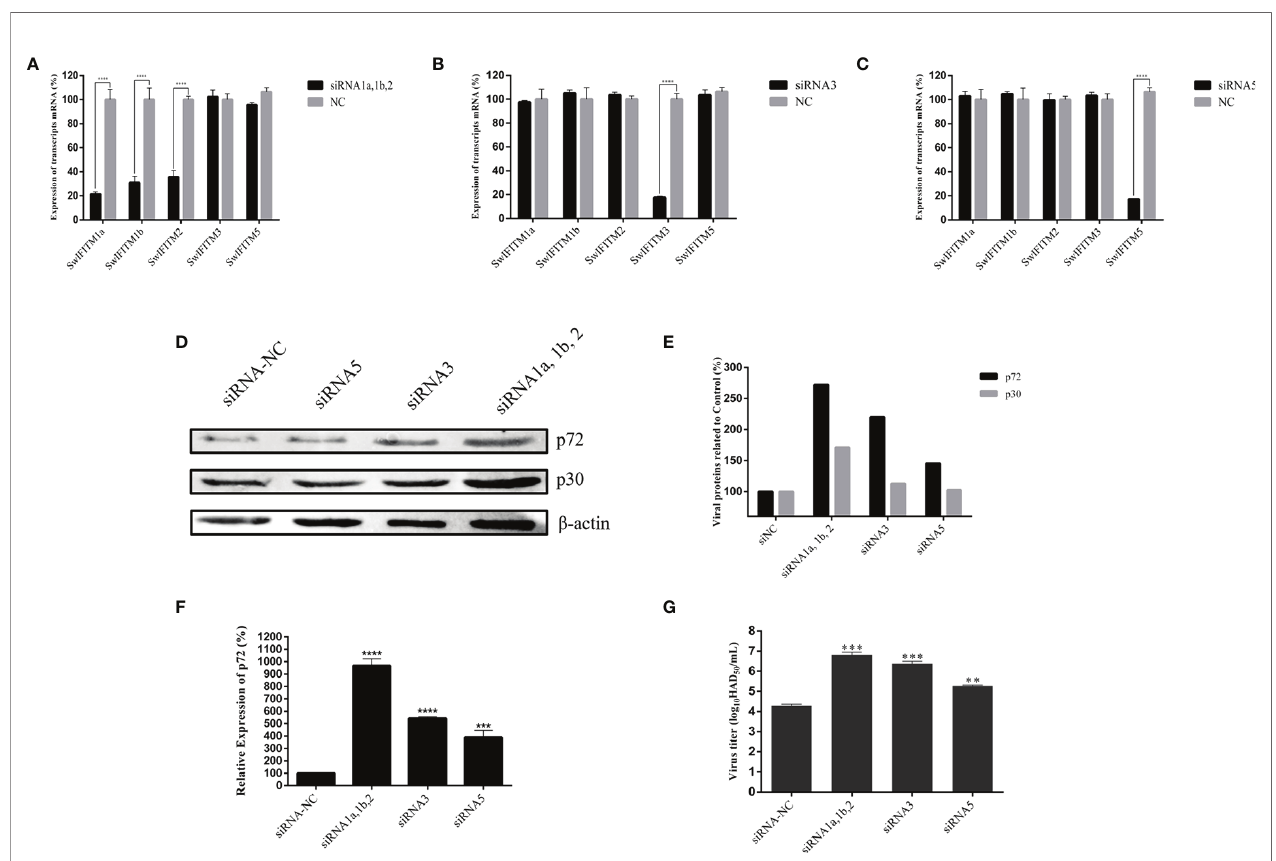
FIGURE 3 | Knockdown of SwIFITMs enhances ASFV replication. (A) SwIFITM mRNA expression levels were evaluated in PAMs 24 h after transfection of 50 nmol of siRNA1a, 1b, 2, or negative control. (B) SwIFITM mRNA expression levels were evaluated in PAMs 24 h after transfection of 50 nmol of siRNA3 or negative control. (C) SwIFITM mRNA expression levels were evaluated in PAMs 24 h after transfection of 50 nmol of siRNA5 or negative control. siRNAs were transfected into PAMs separately for 24 h and then infected with 0.1 MOI of ASFV; the virus replication level of ASFV was determined by (D) RT-qPCR and (E) western blotting with b -actin used as a control at 36 hpi; (F) WB quanti fi cation by densitometry for each viral protein and b -actin, and the density quantitative ratios of each viral protein and b -actin were calculated; (G) the viral titration of progeny virus was tested in HAD assay. Samples were analyzed in triplicate, and three independent experiments were performed. ** p < 0.01; *** p <0.001; **** p <0.0001 vs negative control group. Error bars indicate standard